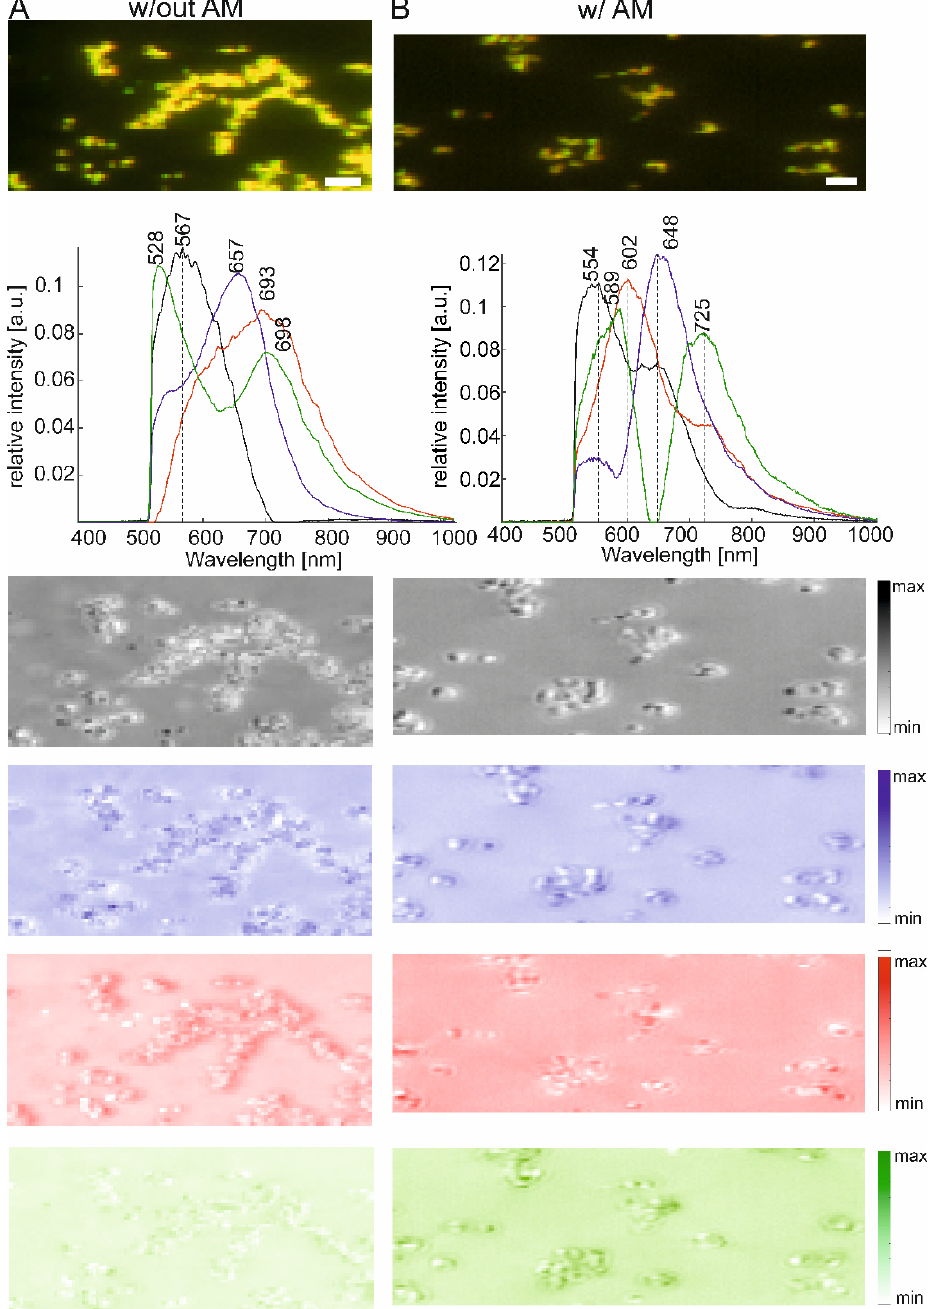
Figure 6. RGB image and NMF components of a dark field scattering data set of silver nanoparticles ( A ) in the presence of MgSO 4 and ( B ) in the presence of MgSO 4 and acrylamide. The sizes of the maps are ( A ) 105 × 49 spectra and ( B ) 176 × 59 spectra. Scale bars: 2 µm. The component around ~550 nm should be ideal to support optical processes that benefit from plasmon resonances in this spectral region, in particular Raman and hyper Raman scattering (HRS), when Stokes-shifted relative to an excitation wavelength of 532 nm and 1064 nm (for two-photon excited hyper Raman scattering, cf. inset in Figure 7B), respectively. Therefore, these vibrational spectra can provide an additional perspective on the properties of the silver nanoaggregates, by characterizing the molecules that may